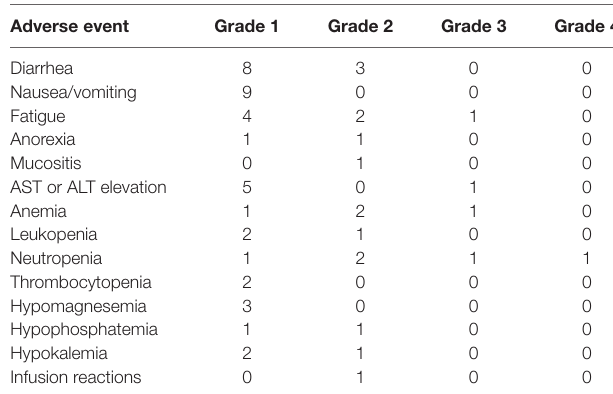
TablE 2 | Treatment emergent adverse events.